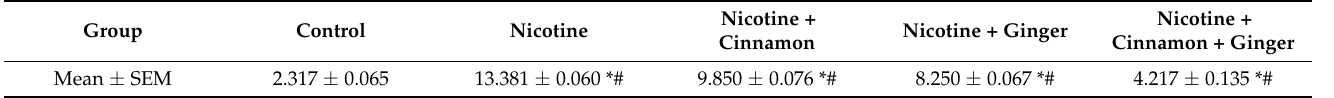
Table 1. MDA level in nmol/gm in the brain tissue of the different groups.